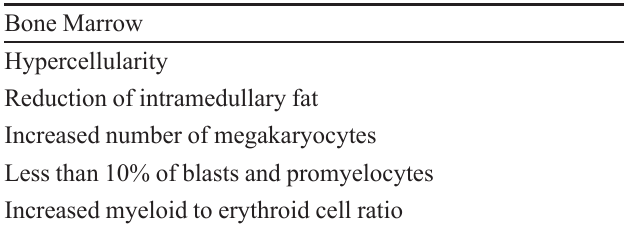
TABLE II - Findings on BMB of CML patients, at a chronic phase